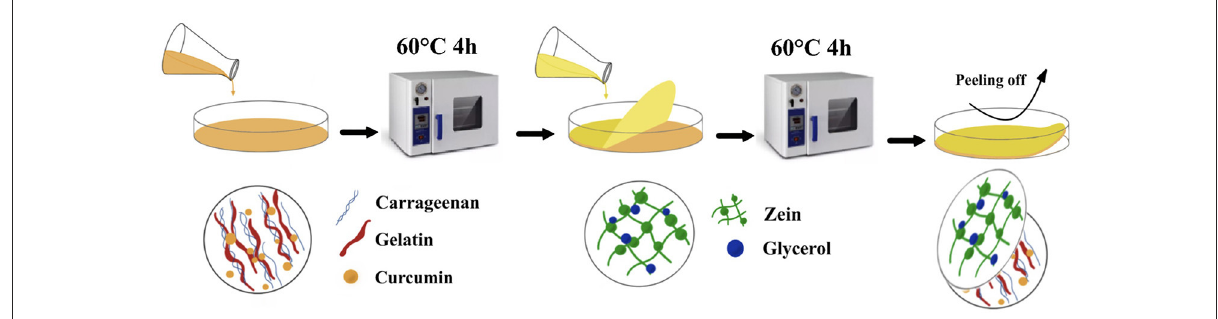
FIGURE5 Preparation of the unidirectionally permeable film.